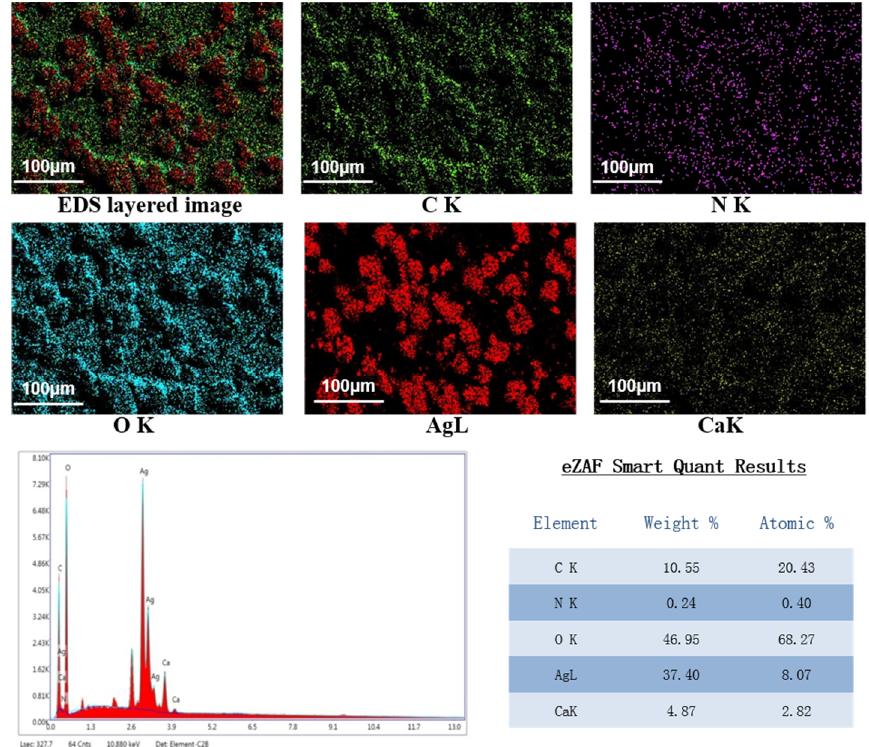
Figure 5. EDS image of SA/AgNPs/APP composite film.